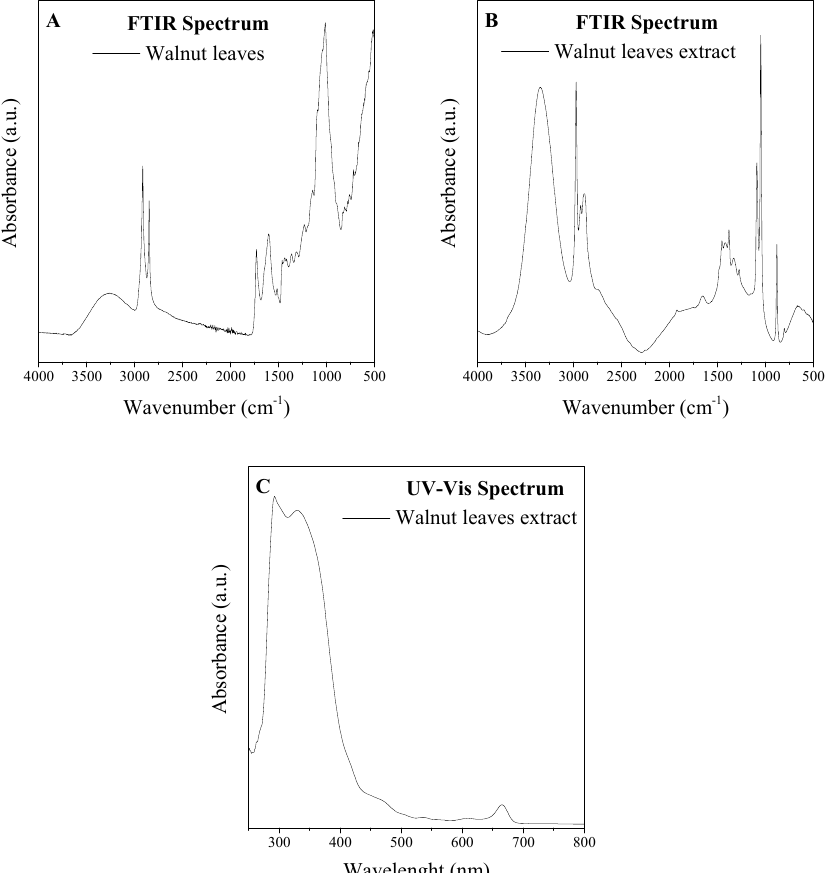
Figure 2. Fourier-transform infrared (FTIR) spectrum of leaves of walnut ( a ) and extract of leaves of walnut ( b ) and ultraviolet visible (UV-VIS) spectrum of extract of leaves of walnut ( c ) .